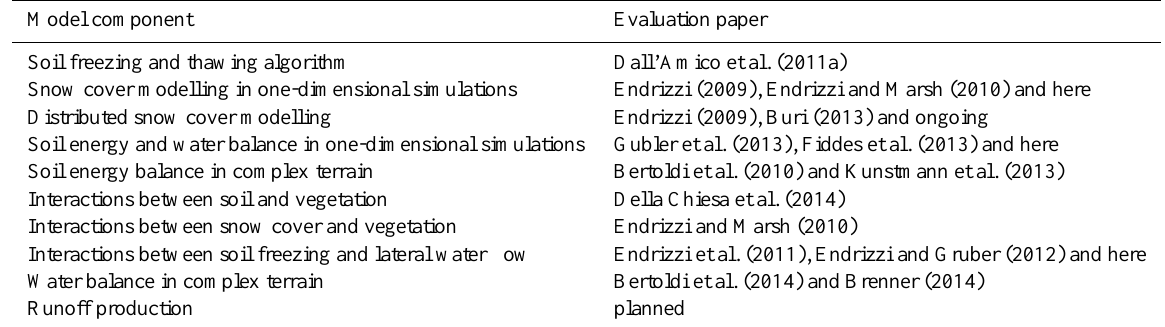
Table 2. List of the major model components or modelled processes, and corresponding publication where they are evaluated, even partially, if